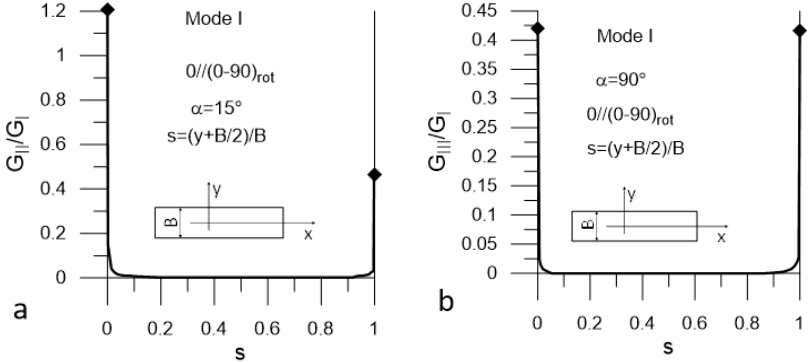
Figure 8. Mode I loading; ( a ) G II /G I (s) ratio and ( b ) G III /G I ratio for Laminate